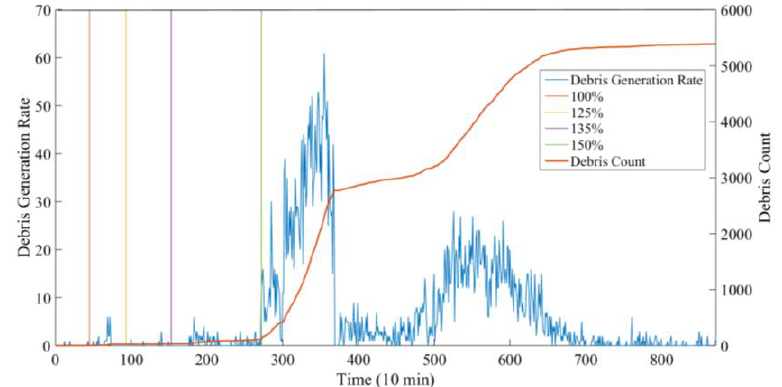
Figure 18. Debris recognition results.